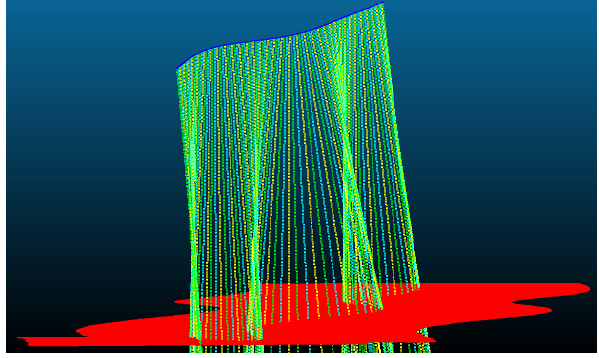
Figure 8. The repeated and missed sampling, alternatively, due to the large pitch and roll angles